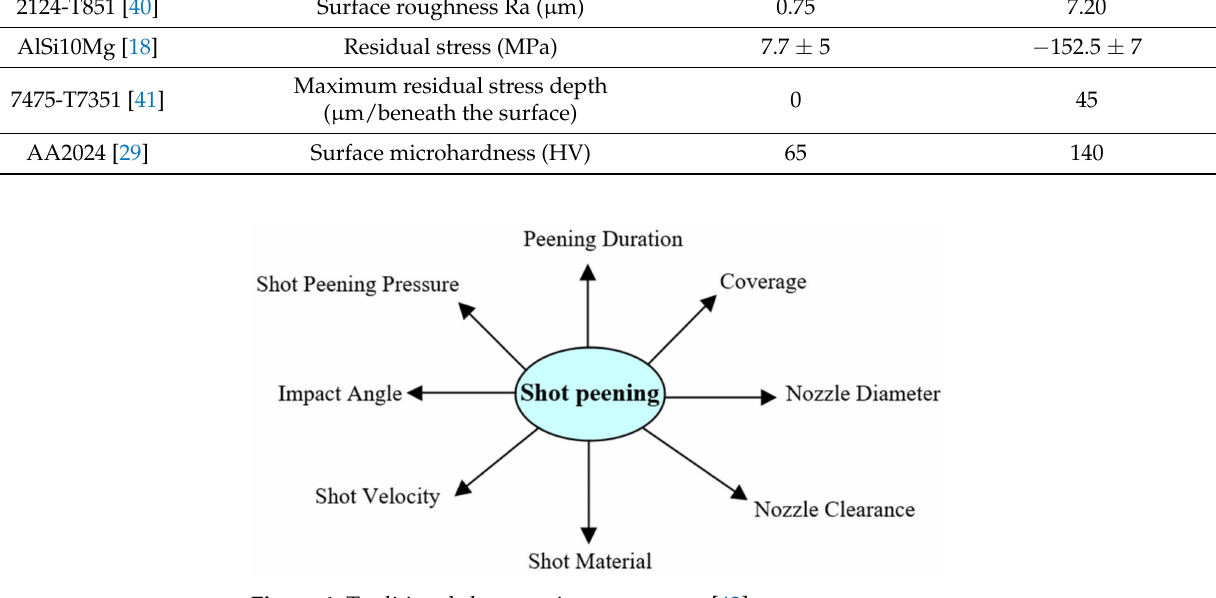
Figure 4. Traditional shot peening parameters